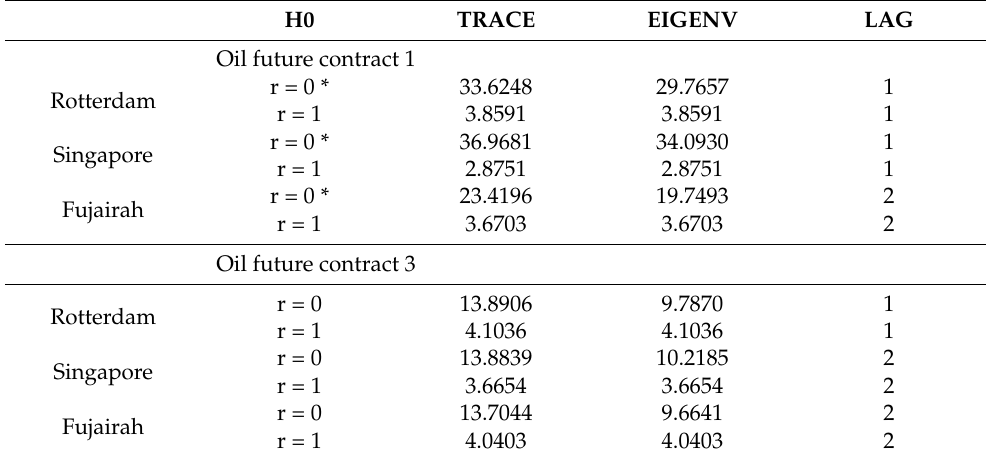
Table 10. The Johansen test results for VLSFO and crude oil future. H0 TRACE EIGENV LAG Oil future contract